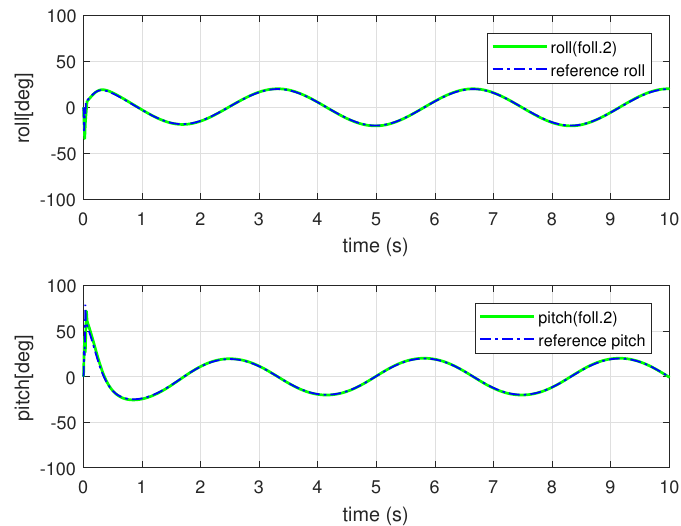
Figure 18. The reference angles of the second follower quadrotors for the formation control about the 6 π circular trajectory: the dashed line indicates the reference attitude angles that enable the second follower quadrotor to converge to the desired formation, and the solid line is the result of the simulation about attitude responses of the second follower quadrotors.